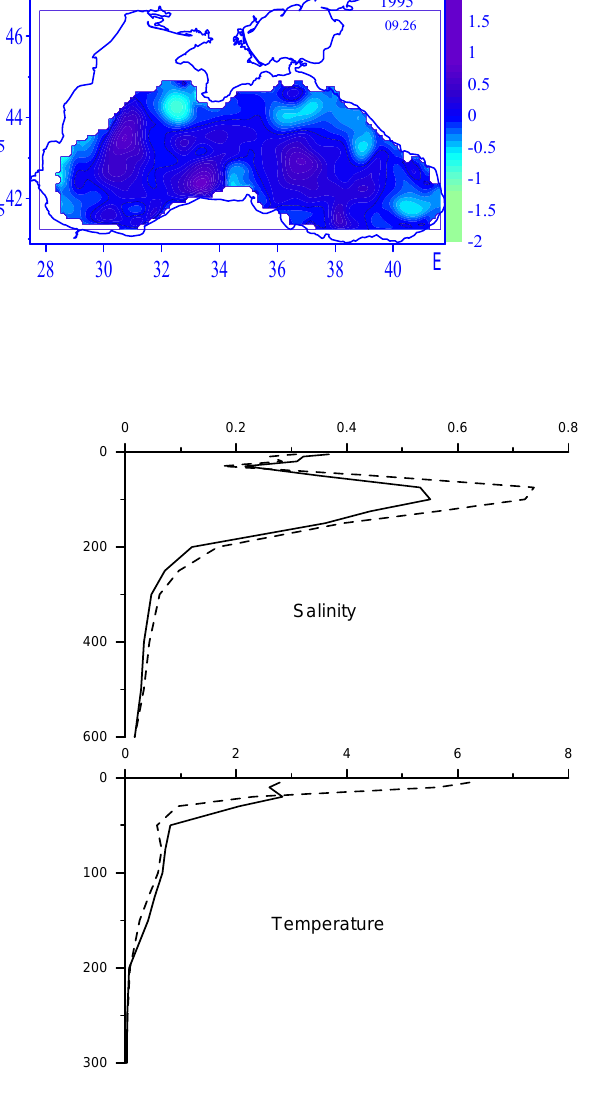
Figure 7 Standard deviation of the differences between simulated and observed fields as a function of Fig. 7. Standard deviation of the differences between simulated depth (solid lines), and the natural variability (root mean square deviation from mean value) of the and observed fields as a function of depth (solid lines), and the nat- same fields (dash lines) (according to Dorofeyev and Korotaev, 2004a) ural variability (root mean square deviation from mean value) of the same fields (dash lines) (according to Dorofeyev and Korotaev,